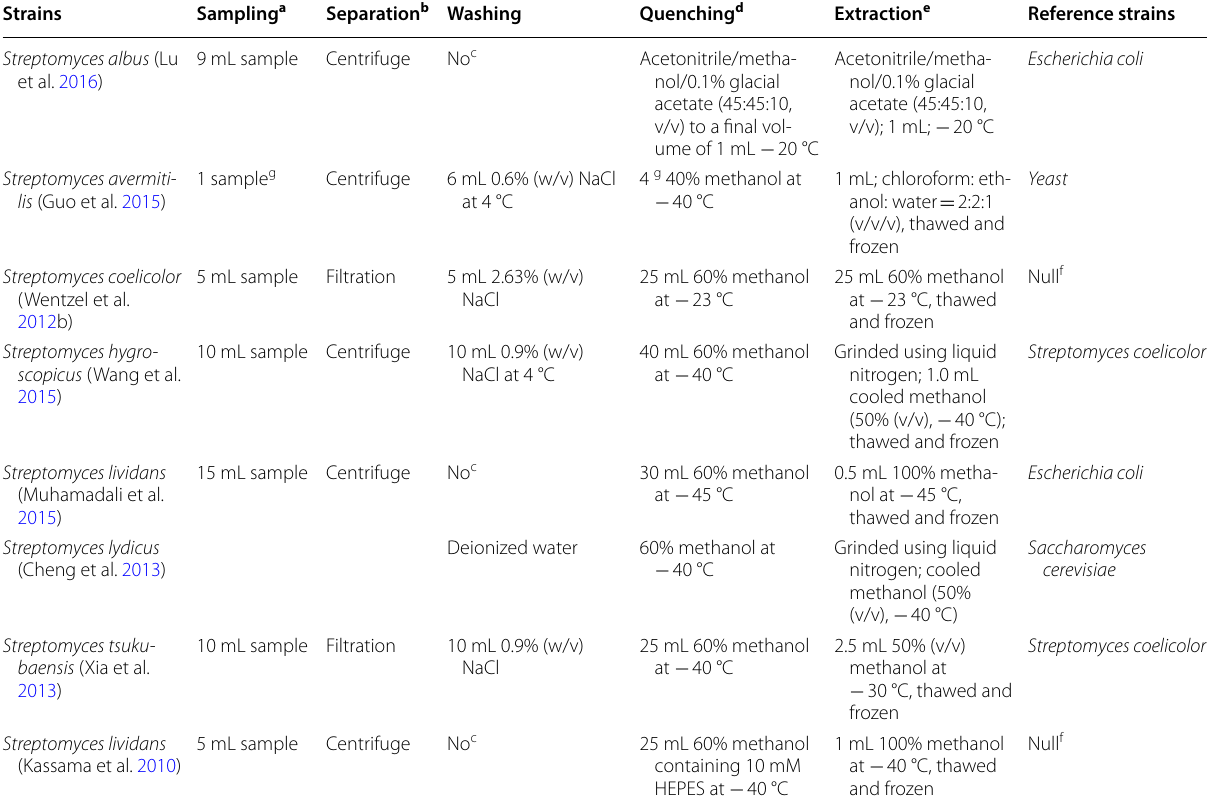
Table 1 Typical procedures of sample preparation for Streptomyces